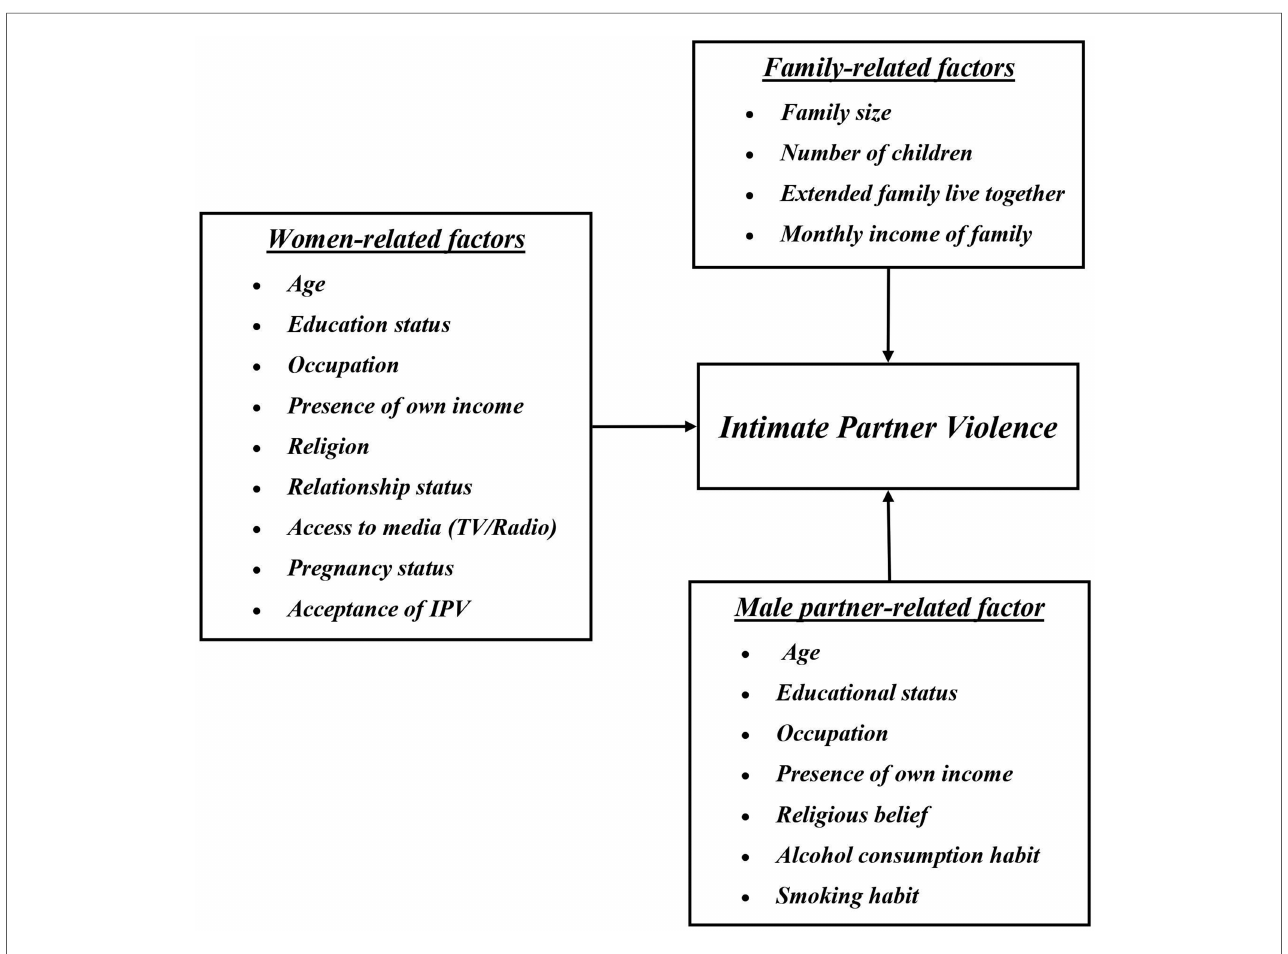
FIGURE 4 Trend of IPV over the fourteen months prior to the data collection among women of reproductive age in Debre Berhan town, Ethiopia,